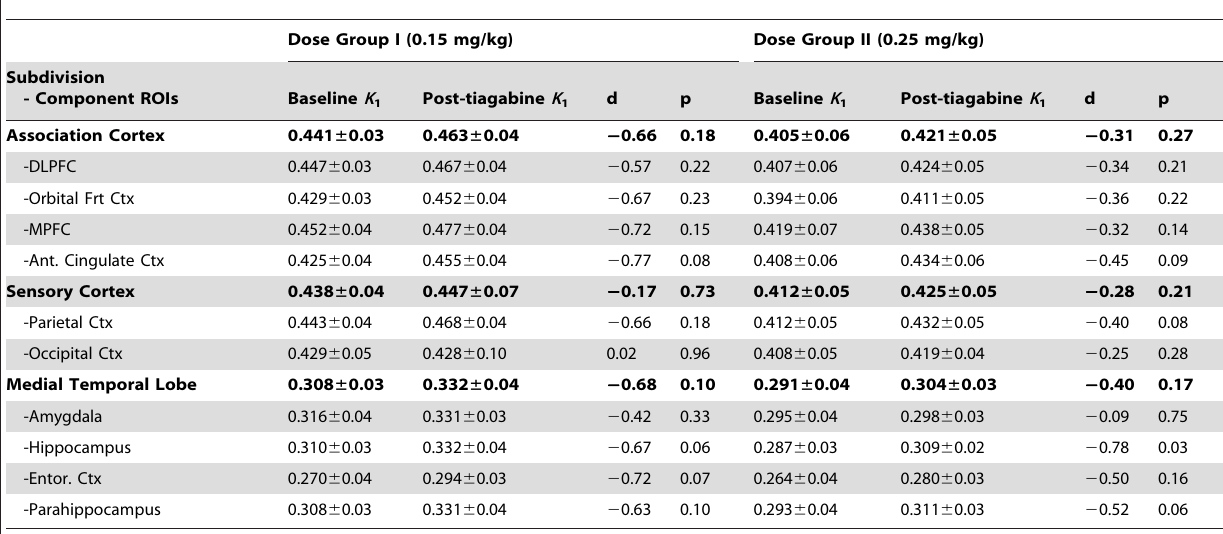
Table 3. Tiagabine-induced change in [11C]flumazenil K 1 in control subjects.